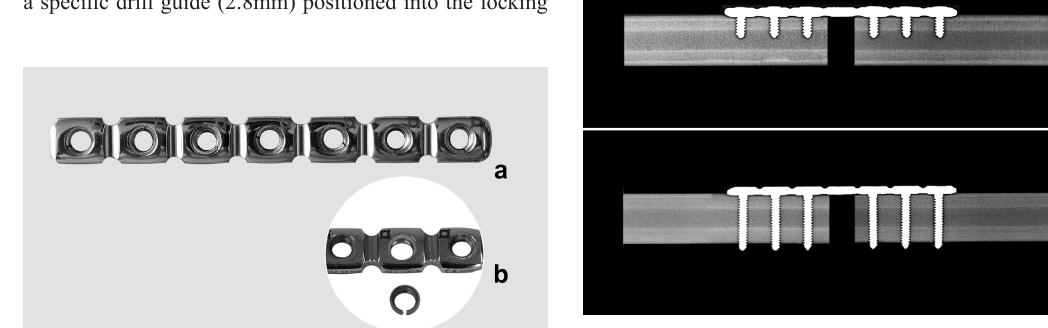
Fig ure 2. Plates assembled according to length of the screws, showed by radiographic depictions: (a) Group 1 – three monocortical screws on each fracture side, (b) Group 2 - three bicortical screws on each fracture